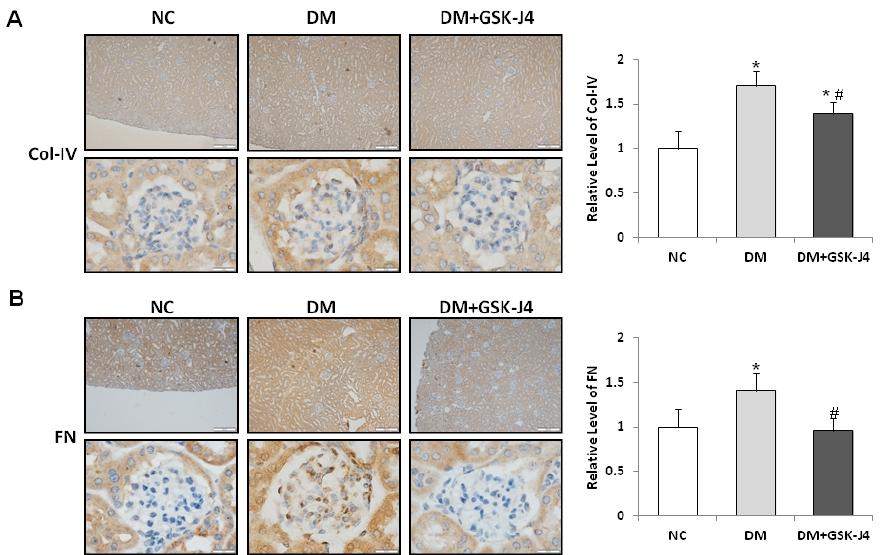
Figure 3. GSK-J4 reduces fibrosis in the glomeruli of STZ-induced diabetic mice. The mice were divided into three groups: normal mice (NC), STZ-induced diabetic mice (DM), and STZ-induced diabetic mice that were treated with GSK-J4 (DM + GSK-J4). Immunohistochemistry detection for fibrosis biomarkers revealed proteins of ( A ) collagen IV (Col-IV) and ( B ) fibronectin (Fn). The right panel shows the relative quantification of fibrosis biomarkers in the tissue immunostaining analysis. The average ratio of the integrated optical density (IOD) to the area (IOD/pixel) was used to analyze the results of immunohistochemistry. The statistical results were compared with the normal control (NC) group. * p < 0.05 versus the control group; # p < 0.05 DM versus DM + GSK-J4. Data are mean ± standard errors calculated from six mice. Abbreviations: DM, STZ-induced diabetic mice; NC, normal mice (enlargement factor: upper, 100×; lower, 1000×).